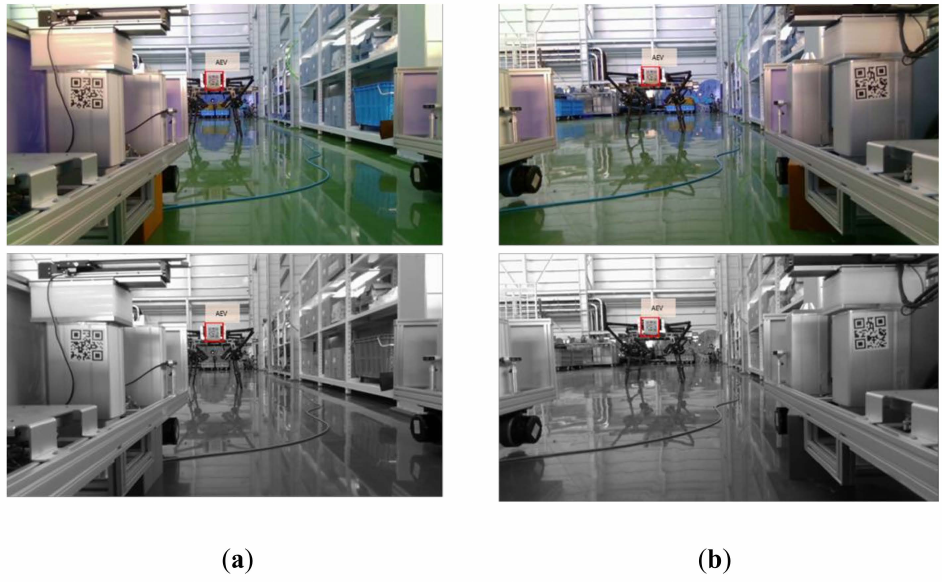
Figure 12. AEV’s marker recognized at a distance of 4 m from the mobile station. ( a ) Left Camera Image, ( b ) Right Camera